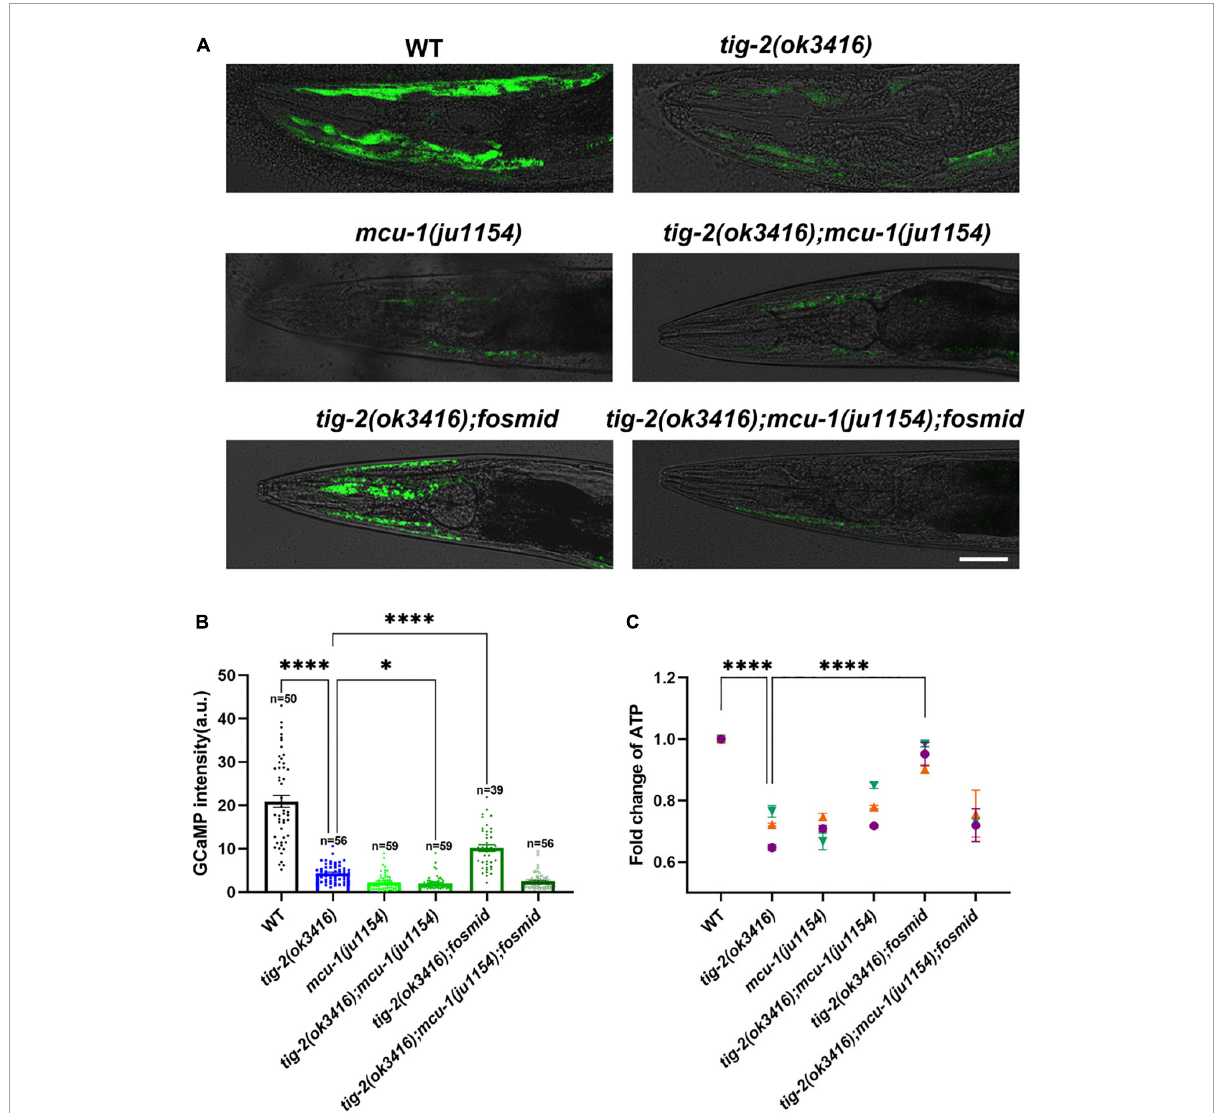
FIGURE6 The content of mitochondrial Ca 2 + and adenosine triphosphate (ATP) production are lower in tig-2 mutants than in wild-type worms. (A) Representative images of GCaMP3 expression. Scale bar = 10 µ m. (B) Quantification of mitochondrial Ca 2 + . The mitochondrial calcium content in tig-2 ( ok3416 ) mutant, mcu-1 ( ju1154 ) mutant and tig-2; mcu-1 double mutants is similar, and much lower than that in wild-type worms ( p < 0.0001). Restoring the expression of tig-2 eliminates the decreased Ca 2 + level in tig-2 signal mutants ( p < 0.0001), but not in tig-2 mcu-1 double mutants ( p = 0.1268). p -values were calculated by one-way ANOVA with multiple comparisons. (C) Relative ATP levels in worms expressing mito:GCaMP3 in their muscle cells. Data represents results from three independent tests. Each test was done in triplicate wells. n = 3 technical replicates. p -values were calculated by two-way ANOVA with multiple comparisons. Error bars represent SEM. *** p < 0.001, **** p <